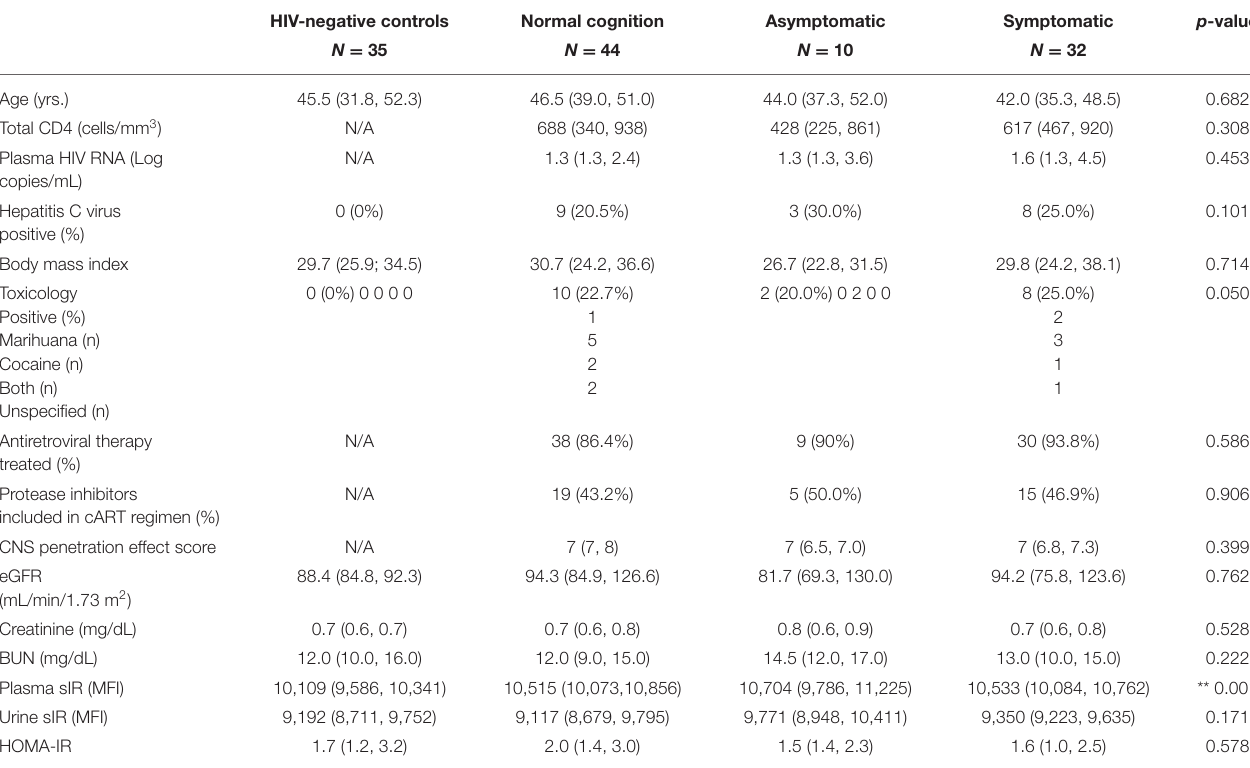
TABLE 1 | Characteristics of HIV-infected women. HIV-negative controls Normal